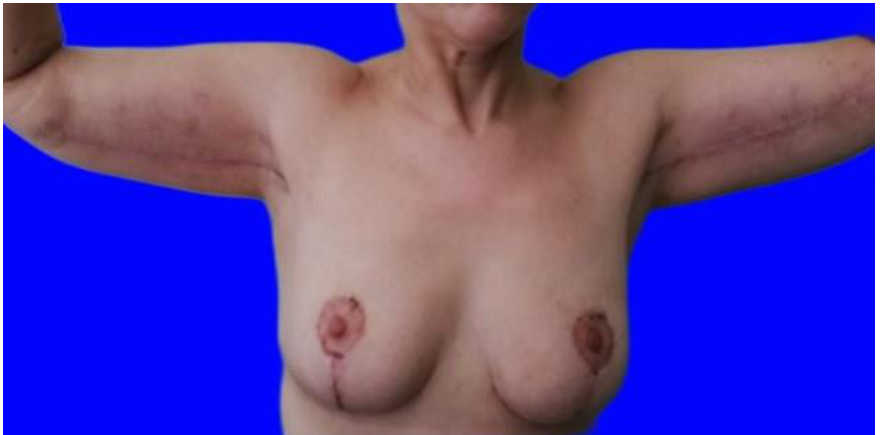
Figure 4. A patient 12 months after the intervention.